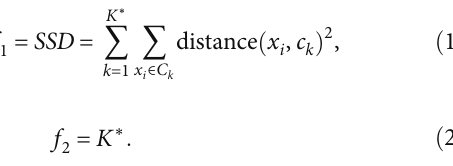
Algorithm. The algorithm fl ow of multiobjective